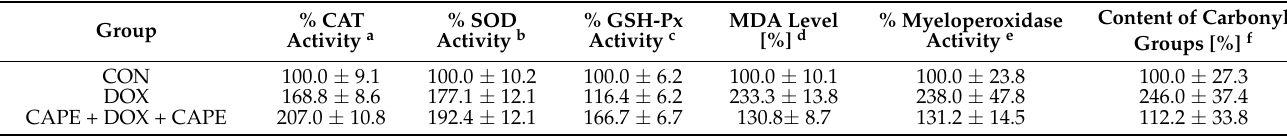
Table 14. Effect of phenylethylene phenylethyl ester (CAPE) on the level of biomarkers of cardiotoxicity in the hearts of DOX treated rats